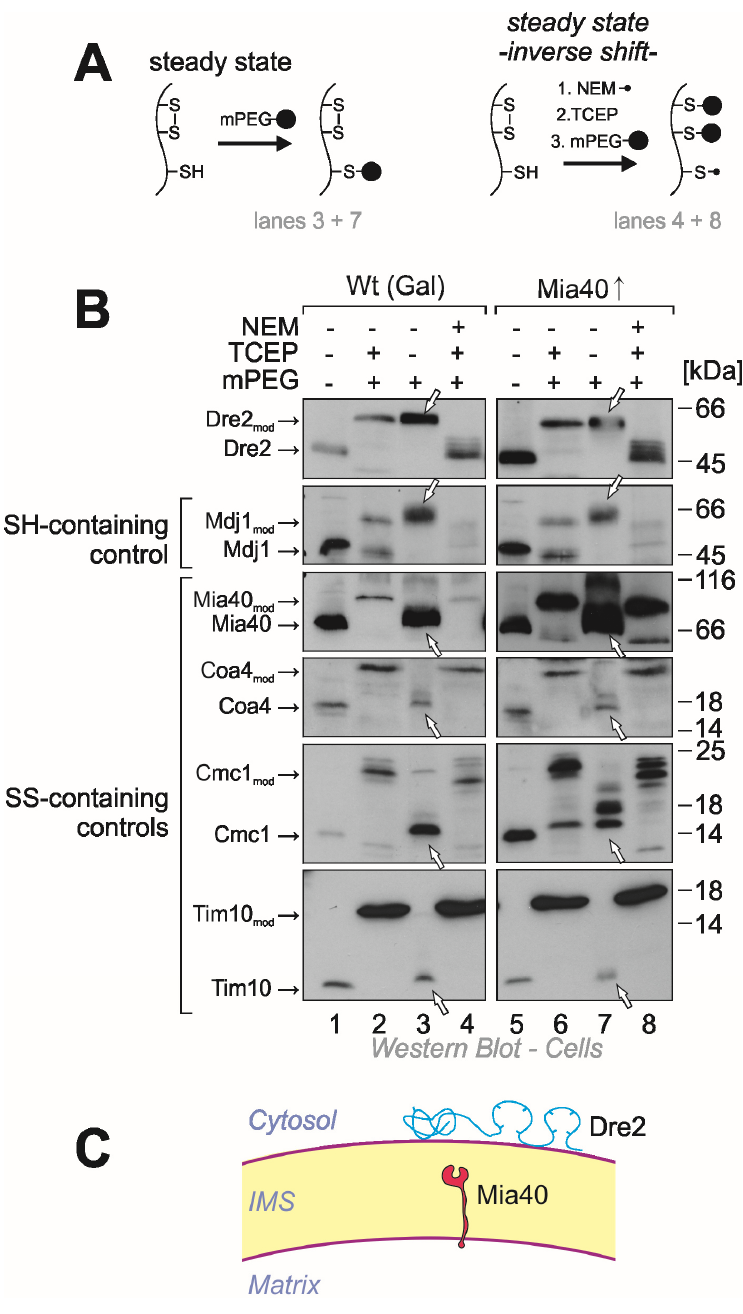
FIGURE 3: The cysteine residues in Dre2 are reduced at steady state conditions. (A) Scheme showing the modifications of reduced and oxidized protein thiols by treatment with the alkylating agents mPEG and NEM and the reductant TCEP. (B) Wild type or Mia40- upregulated cells in which Dre2 was overex- pressed were harvested, acid treated with TCA to preserve the redox state of thiol groups and incubated with the indicated chemicals in subsequent reactions. Lanes 1 and 5 show non-modified proteins thereby serving as size standards for completely oxidized proteins. Lanes 2 and 6 show complete alkylation with mPEG-24 and hence the size expected for proteins in which all cysteines are reduced. Lanes 3 and 7 show the steady state of the proteins in the cell, lanes 4 and 8 the inverse shift after blocking thiols with NEM and open- ing of disulfides with TCEP. Arrowheads point at the signals of the steady state species which indicate that all thiols in Dre2 are present in the reduced form. (C) Schematic representa- tion of Dre2 on the mitochondrial surface. Reduced cysteine residues are indicated. Our observations suggest that Dre2 does not con- tain structural disulfide